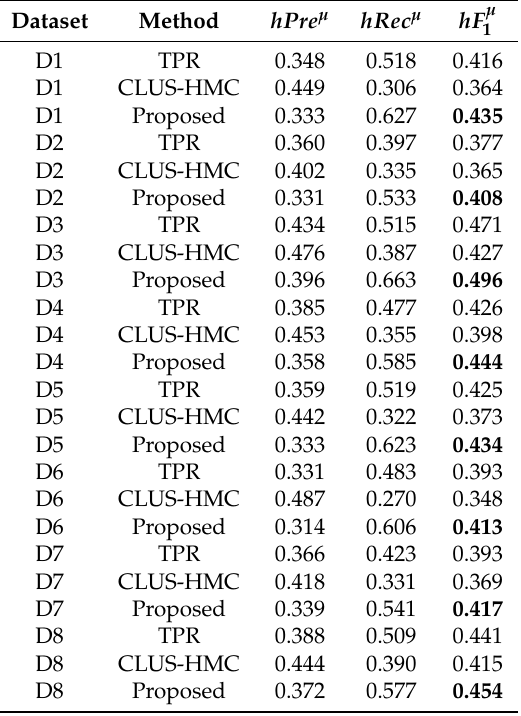
Table 4. The macro-averaged version of experimental results on eight data